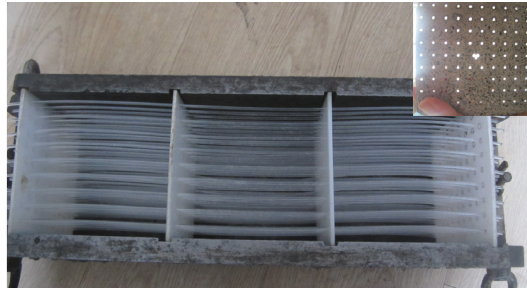
Figure 3: Fabrication of POF transparent concrete.